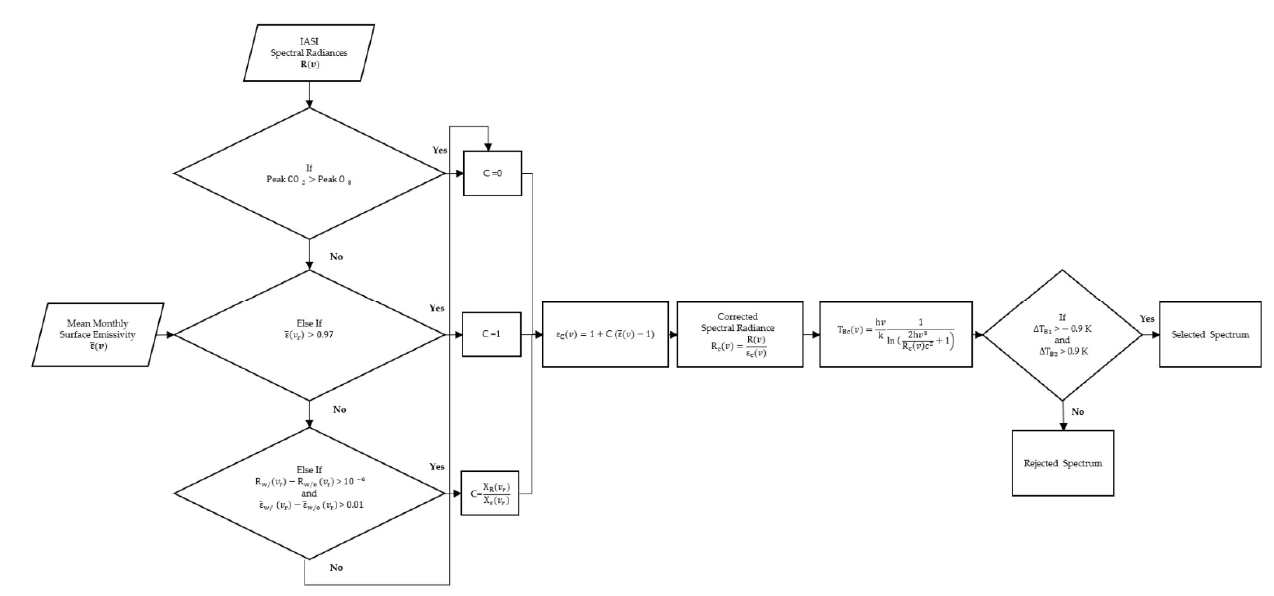
Figure 5. LSE correction scheme diagram.